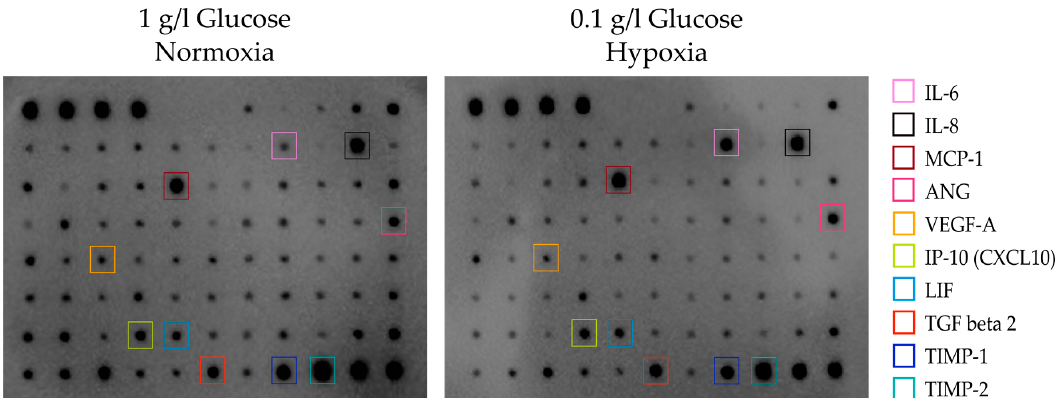
Figure 4. Human cytokine antibody array. Array membranes covering 80 cytokines were probed with supernatants of ASCs collected under control conditions (1 g/L glucose/ 21% O 2 ) and glucose/oxygen deprivation (0.1 g/L glucose/ 0.2% O 2 ) ( n = 2). Prominently appearing spots with similar or higher intensity in the deprivation condition were highlighted.